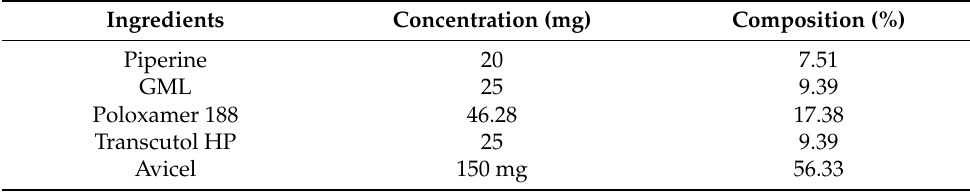
Table 5. Composition of optimized S-PE-SNEDDS (SOF3).